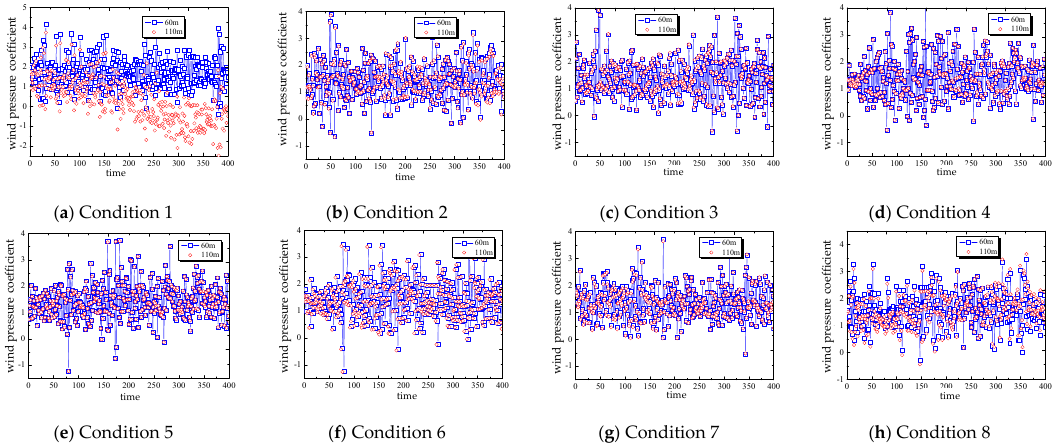
Figure 14. Time-history curve of wind pressure coefficient on the windward side of tower under different condition.